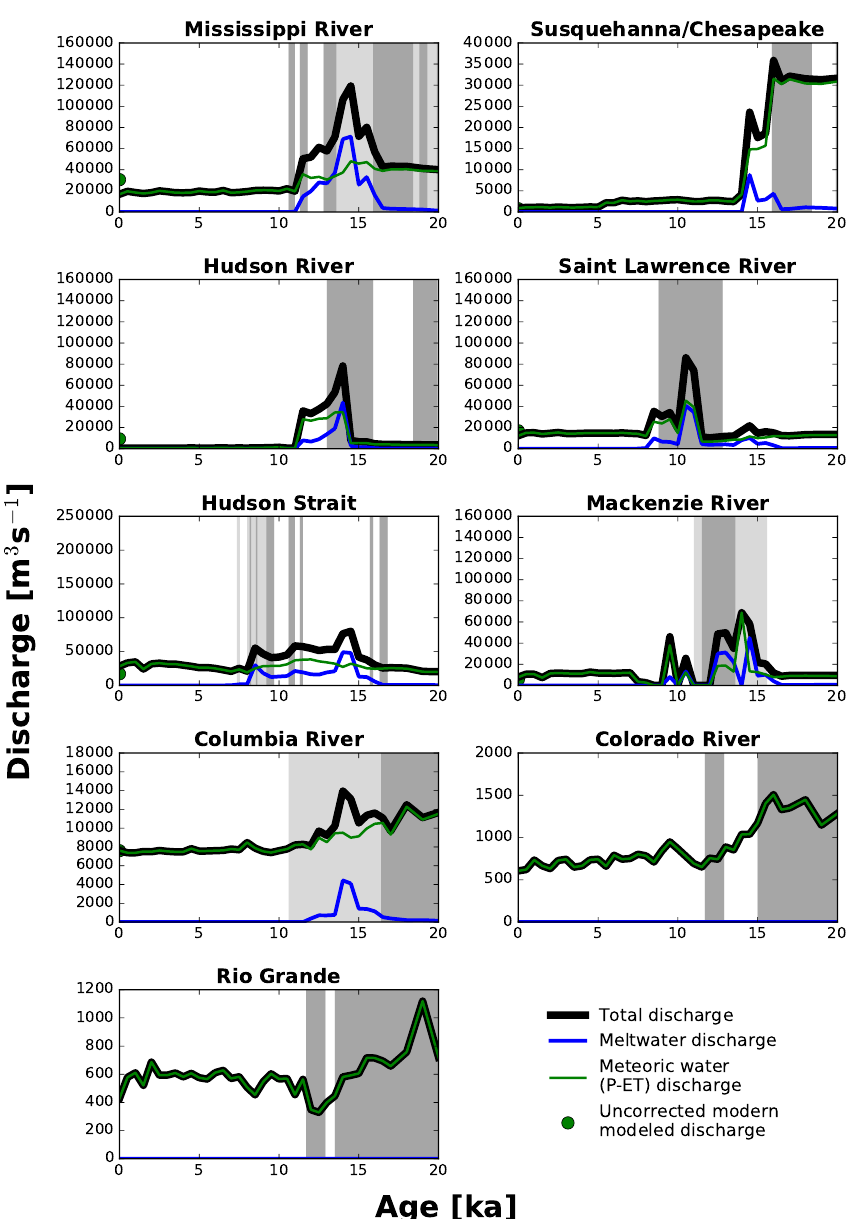
Figure 13. Computed discharge based on ICE-5G/VM2 (Peltier, 2004), compared to the geologic record of enhanced past discharge (gray shading: dark, direct record; light, inferred and/or less-enhanced discharge). Notes on the geologic record can be found in Fig.